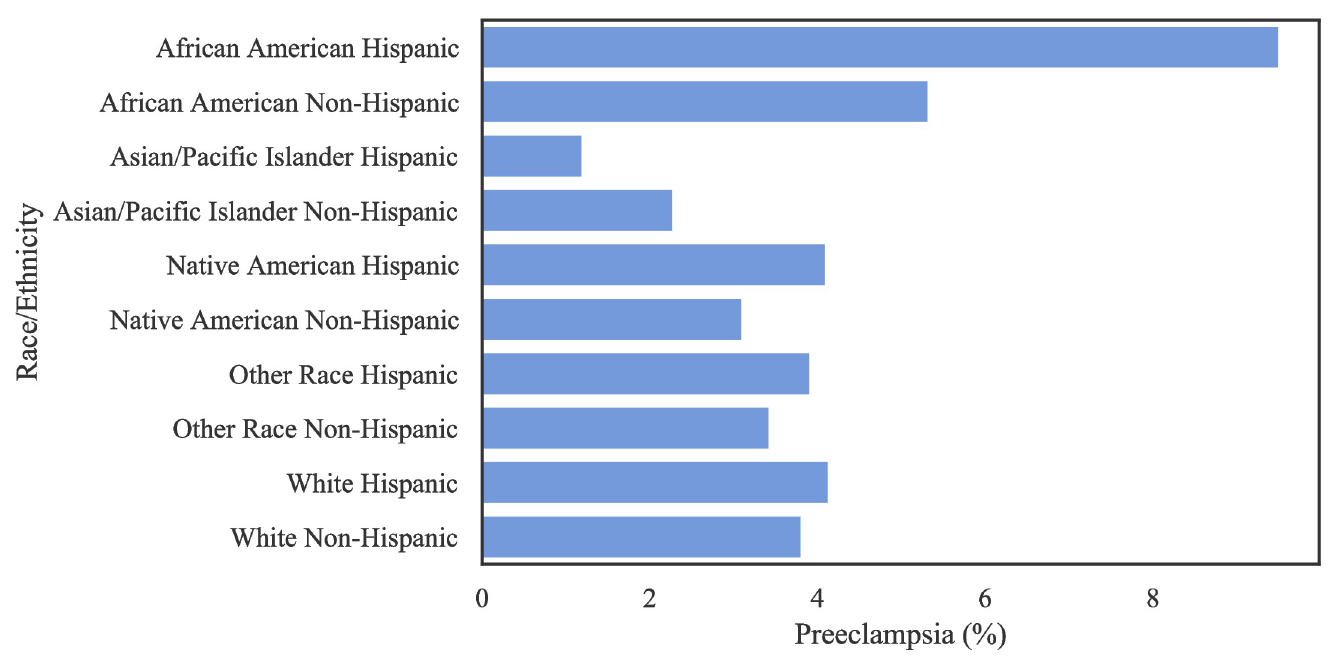
Fig 3. The rate of PE per race/ethnicity in the Texas